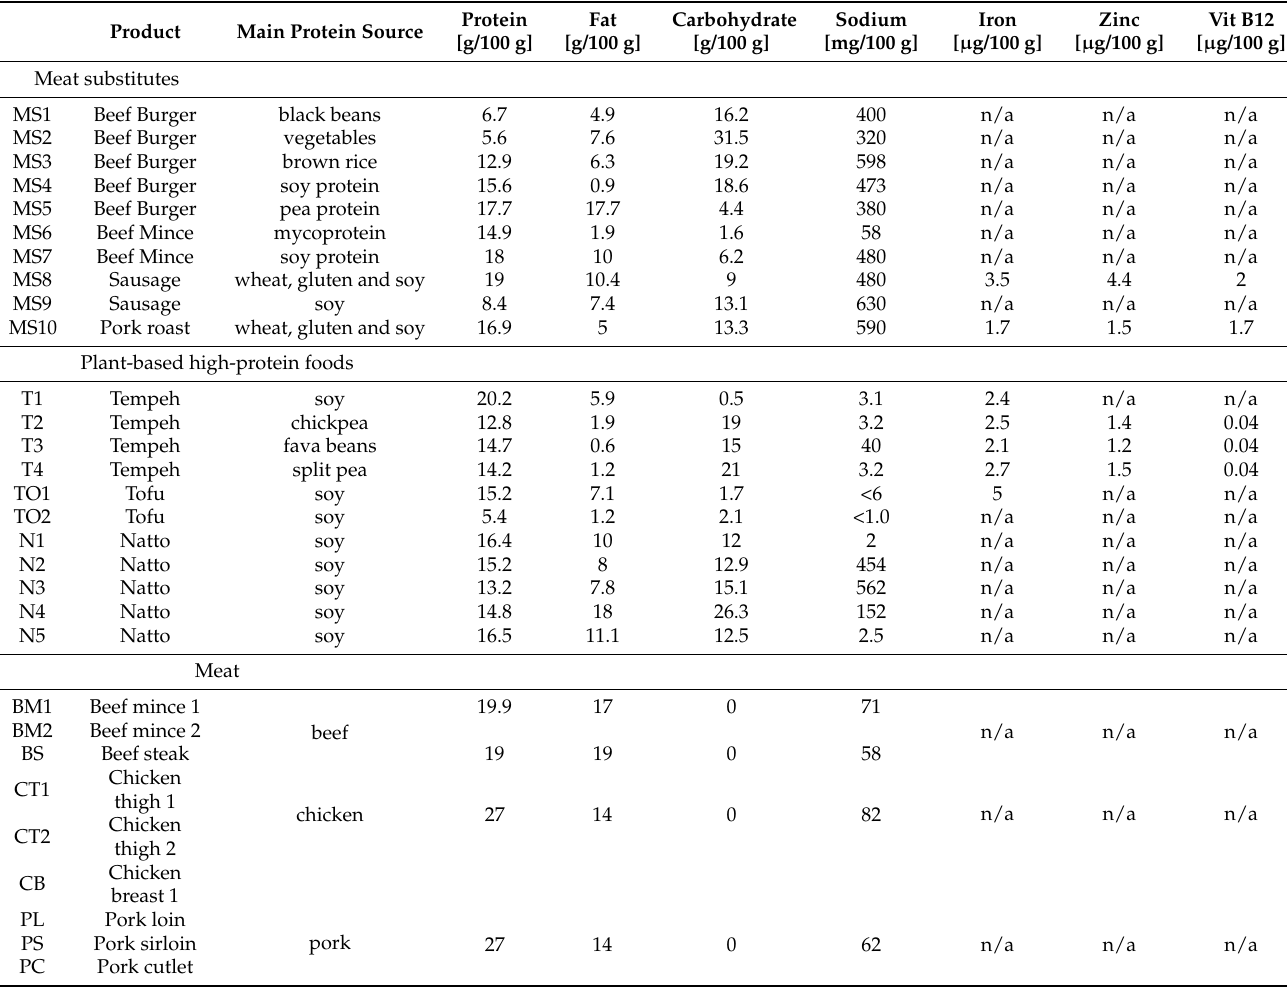
Table 1. Nutrition information of meats, meat substitutes, and traditional plant-based high-protein